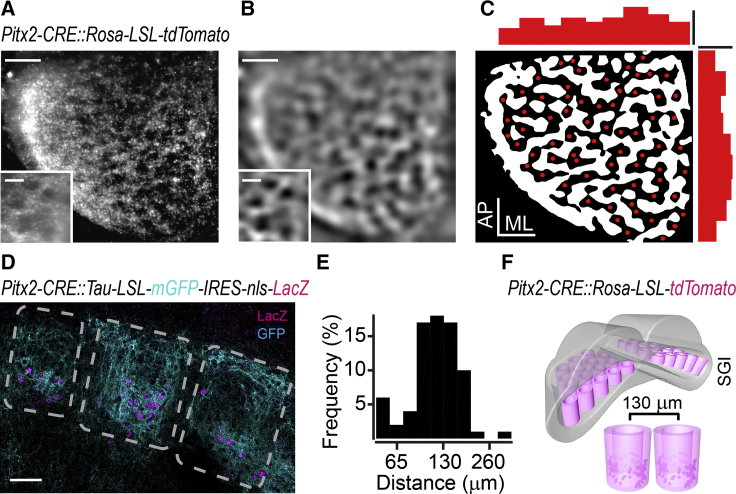
Pitx2ON Neurons Are Organized in Discrete Anatomical Modules in the SGI(A–C) Projection of top SC view in clarified brain of Pitx2-CRE::Rosa-LSL-tdTomato (A), Gaussian filtered image (B), image segmentation and centroid detection of Pitx2OFF zones using the local minima criterion (red dots) and distribution density of Pitx2OFF zone centroids in the medial-lateral (ML) and anterior-posterior (AP) SGI coordinates (scale bars = 300 μm; density = 30 centroids/mm2; (C). Insets represent a magnified top view portion of SC highlighting the Pitx2ON and Pitx2OFF zones with a grid-like organization (scale bar = 130 μm).(D) Modular organization of Pitx2ON neurons dendrites (cyan, mGFP) and cell bodies (magenta, LacZ) from a coronal section of Pitx2-CRE::Tau-LSL-mGFP-IRES-nls-LacZ mice (scale bar: 100 μm).(E) Distribution of distances of each of the detected Pitx2OFFzone centroids in (C) from the nearest centroid.(F) Three-dimensional representation of the mouse SC based on clarified brain of Pitx2-CRE::Rosa-LSL-tdTomato. The SGI is populated by Pitx2ON neurons (magenta dots represent the cell body) organized in discrete anatomical modules (magenta barrels) the center of which is categorized as a Pitx2OFFspace. Pitx2OFFspaces appear as non-fluorescent zones whose centroids distance is 130 ± 7 μm on average (nMICE = 3).